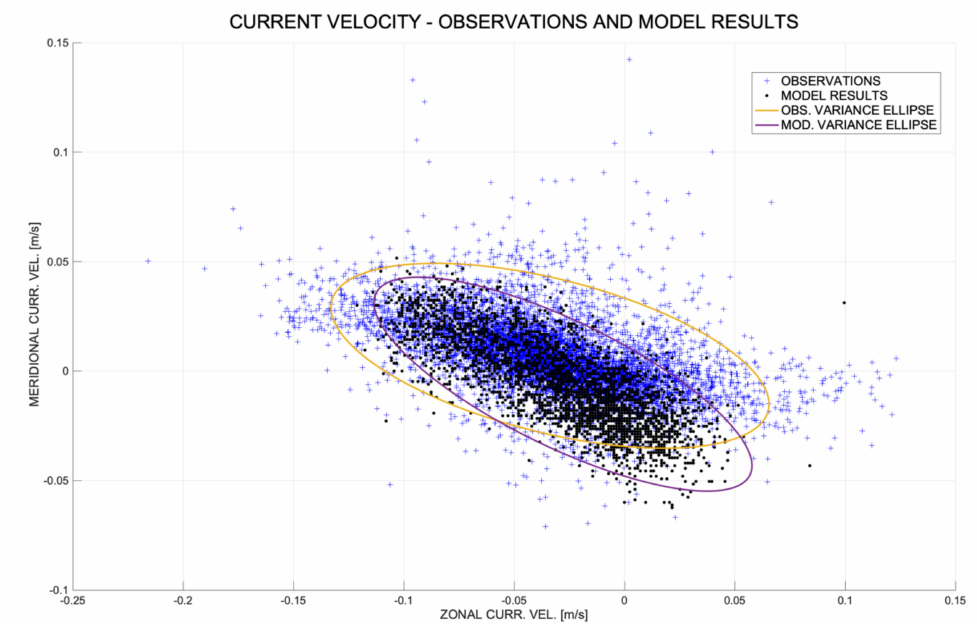
Figure 5. Comparison between model results (black dots) and observed current speed (blue dots) measured at the station U located inside Ushuaia Bay at 120 m depth. Model results consist of data simulated for the period between May and November 2016 (black dots). Observed values consist of the current speed measured between May and November 2017 (blue dots). Superimposed are the variance ellipses of the modeled (blue line) and measured (green line) current speeds